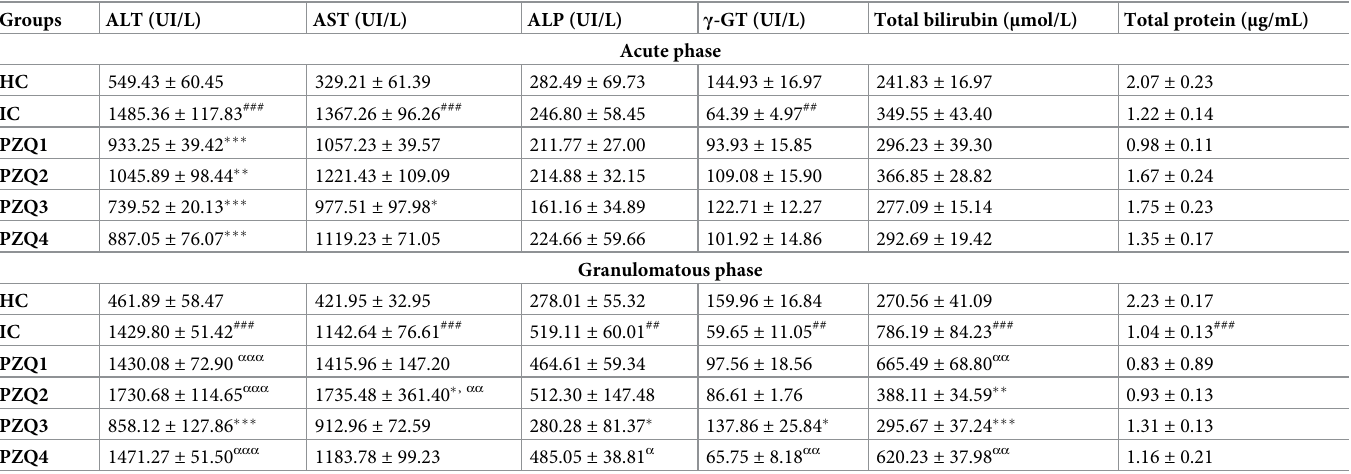
Table 5. Effect of praziquantel treatment on the liver function of Schistosoma mansoni -infected mice.